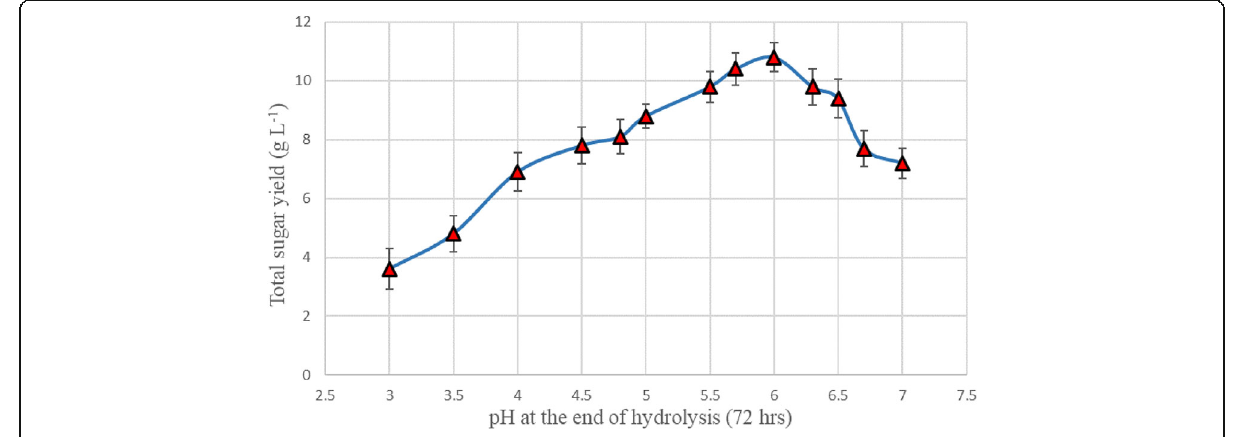
Fig. 6 Total reduced sugar concentration for different pH solution at the end of the hydrolysis (72 h)